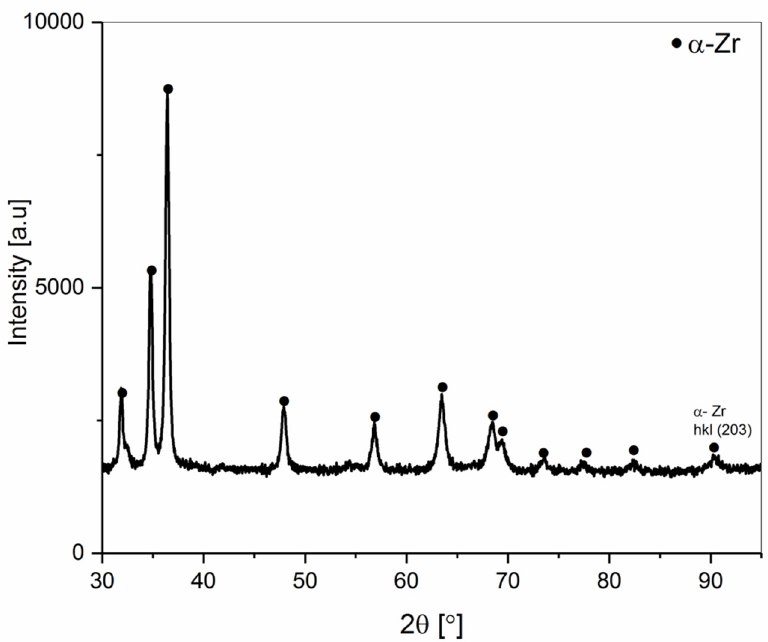
Figure 9. The X-ray di ff raction pattern for the test sample obtained from Zr 1 powder with marked Figure 9 . The X-ray diffraction pattern for the test sample obtained from Zr 1 powder with marked peak accepted as a reference point for stress peak accepted as a reference point for stress measurement.